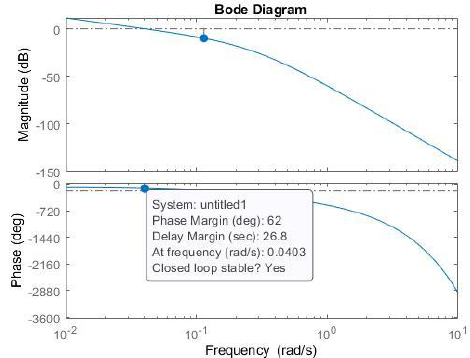
Figure 8. Bode diagram of the open-loop system for the third designed FO-PI controller.